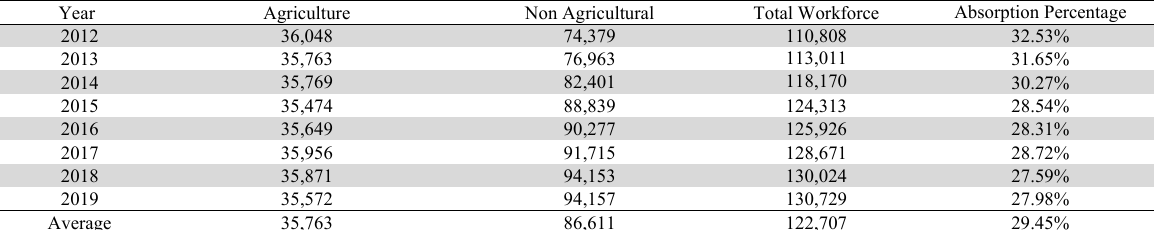
Source: Ministry of Agriculture (2019)